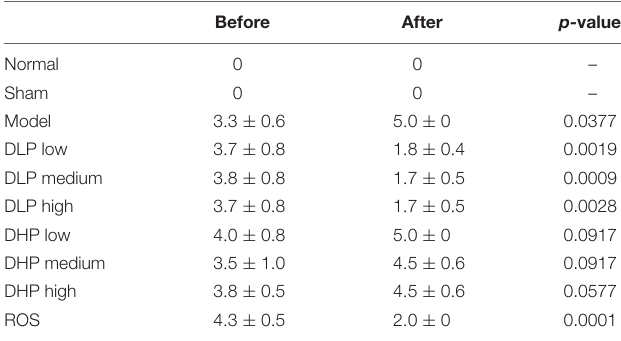
TABLE 1 | Comparison of µ CT findings before and after administration of ROS, DLP or DHP on BLM-induced lung fibrosis in mice. Before After p- value Normal